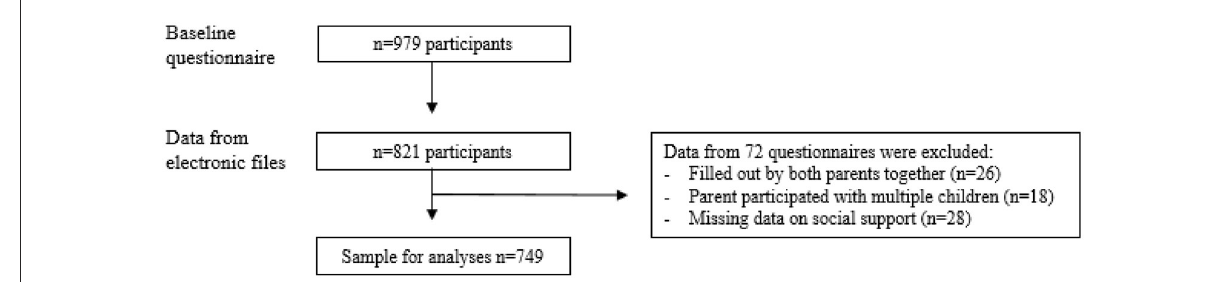
FIGURE1 Flowchart of the inclusion process of the CIKEO cohort study and the final sample for analyses ( n =